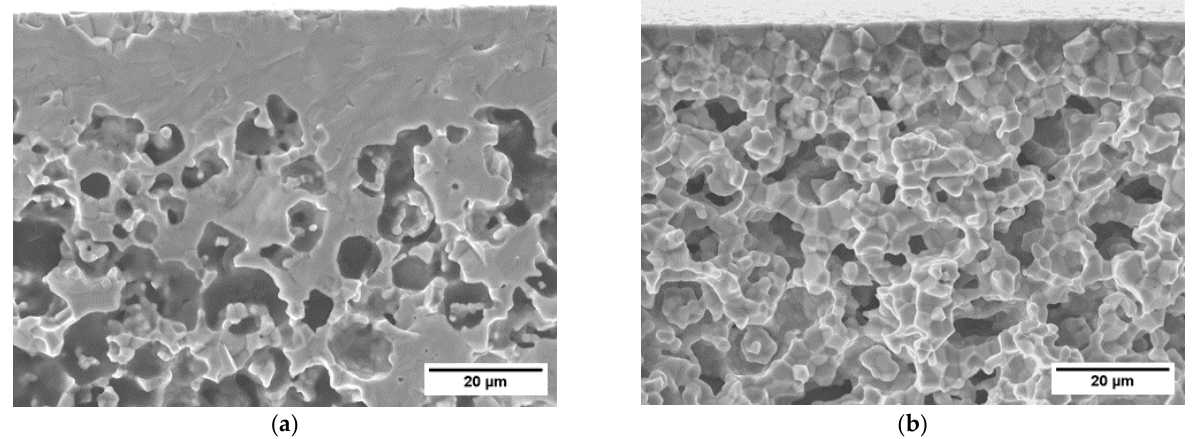
Figure 13. SEM images of fracture surfaces of LSCF specimens after four-point bending tests at ( a ) room temperature ( a ) and ( b ) 950 °C.